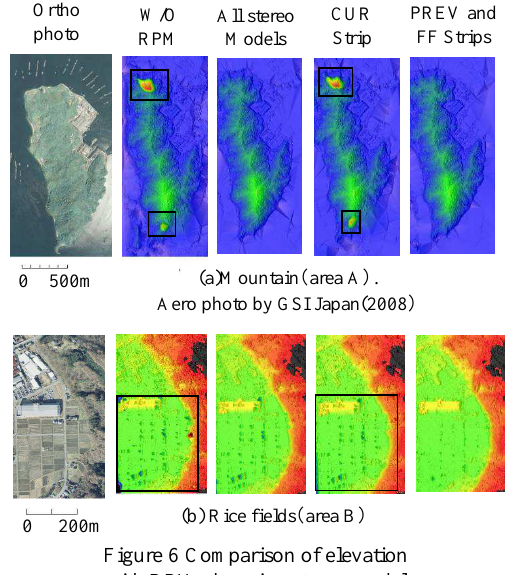
Figure 6 Comparison of elevation with RPM changing stereo